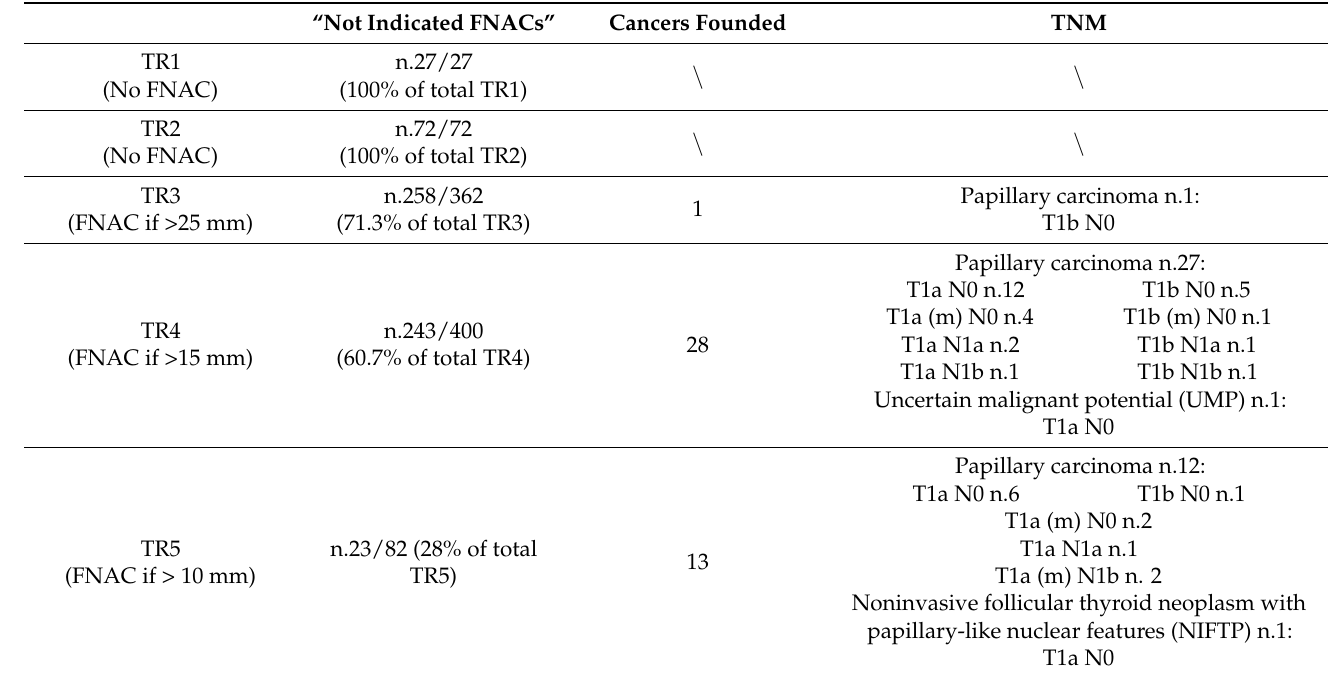
Table 3. ACR TI-RADS classification of “not indicated FNACs”, cancers found, and TNM. “Not Indicated FNACs”